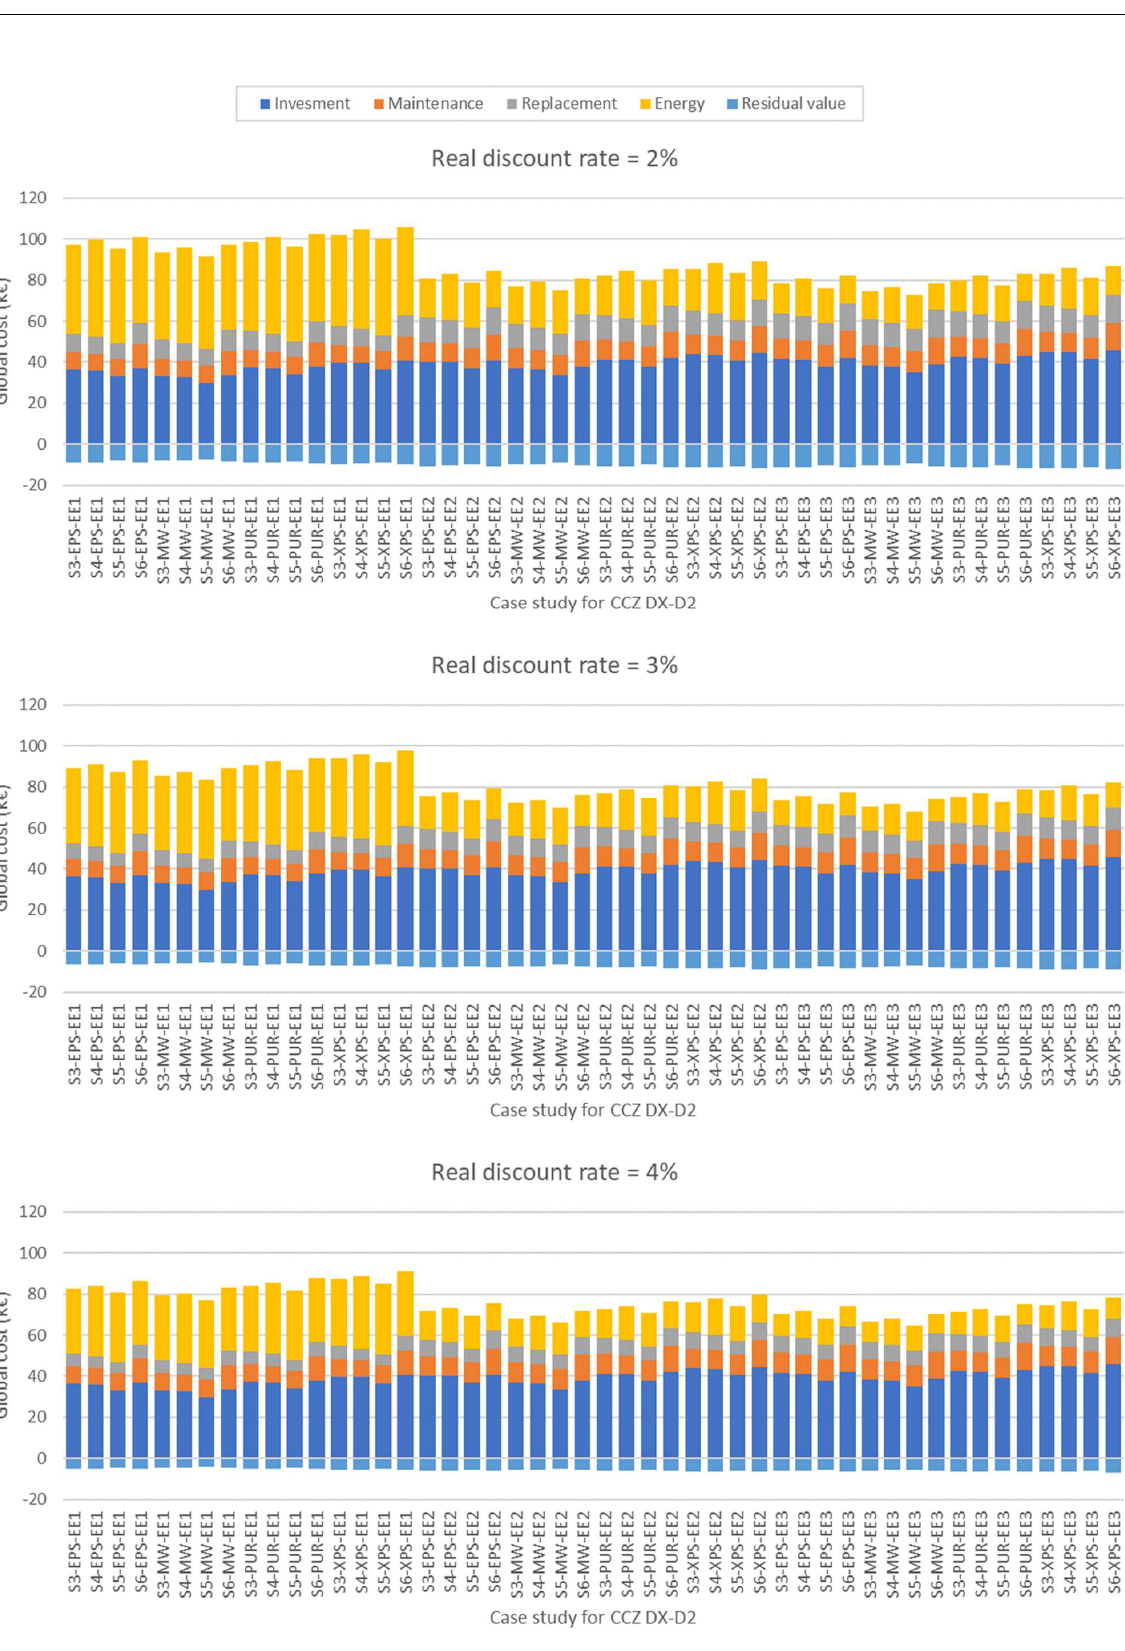
Figure 6. Global cost breakdown by the different costs and residual value, in EUR 1000, for each energy renovation solution in CCZ DX-D2 by real discount rate.